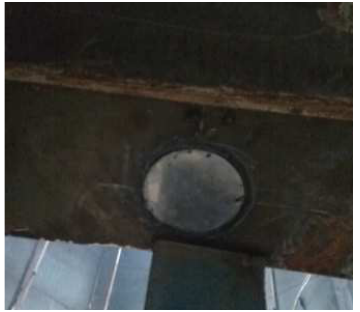
Figure 6. Installing completion of soil pressure cell.